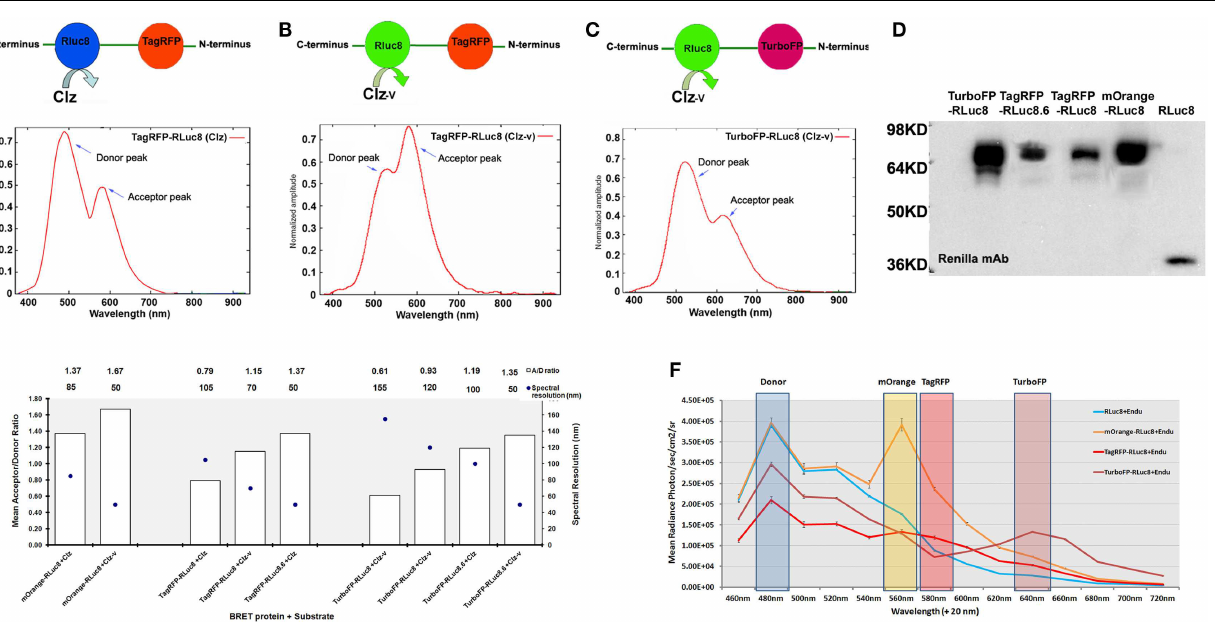
FIGURE 1 |Various new generation of BRET pairs reported using mutant Renilla luciferase proteins . (A) RepresentsTagRFP-RLuc8 pair using normal coelenterazine (Clz) substrate.The bottom chart represents normalized amplitude vs. wavelength measured from the purified fusion protein added with Clz substrate. (B) Represents the same pair using the coelenterazine- v (Clz- v ) substrate analog. (C) RepresentsTurboFP-RLuc8 pair using the Clz- v substrate.The chart represents normalized amplitude vs. wavelength measured from purified protein with Clz- v substrate. Note that in majority cases [e.g., (A) or (C) ], typical normalized amplitude emission of the donor is higher than the acceptor emission output, whereas in some cases [e.g., (B) ], due to efficient transfer of energy, normalized amplitude of acceptor emission is higher than the donor emission. (D) Represents western blot analysis of various BRET fusion proteins made by combining mutant Renilla luciferases (such as RLuc8 and RLuc8.6) with mOrange,TagRFP, andTurboFP fluorescence acceptors. As control, RLuc8 (RL8) protein of 35kDa size was also shown on the right most lane. (E) BRET ratios (denoted as A/D ratio on Y -axis) are calculated by measuring the donor and acceptor E mmax from each of these fusions in the presence of indicated Clz (or its analog) substrate from mammalian